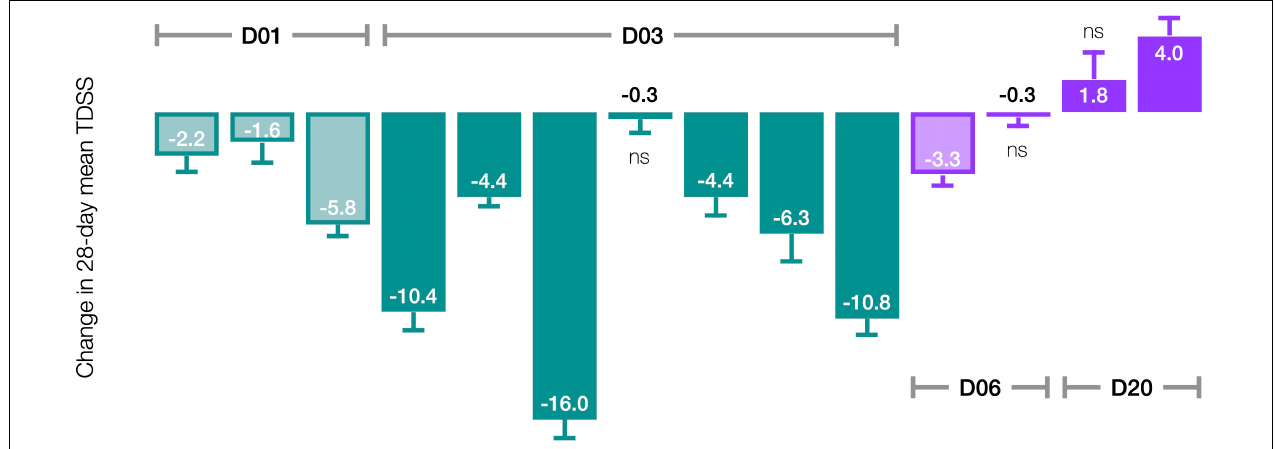
FIGURE 5 | Effect of CT38 on the pre-/post-treatment change in the 28-day mean TDSS (bars), with standard deviations (error bars), by patient. All changes are statistically significant ( p < 0.05), except ns (not significant).